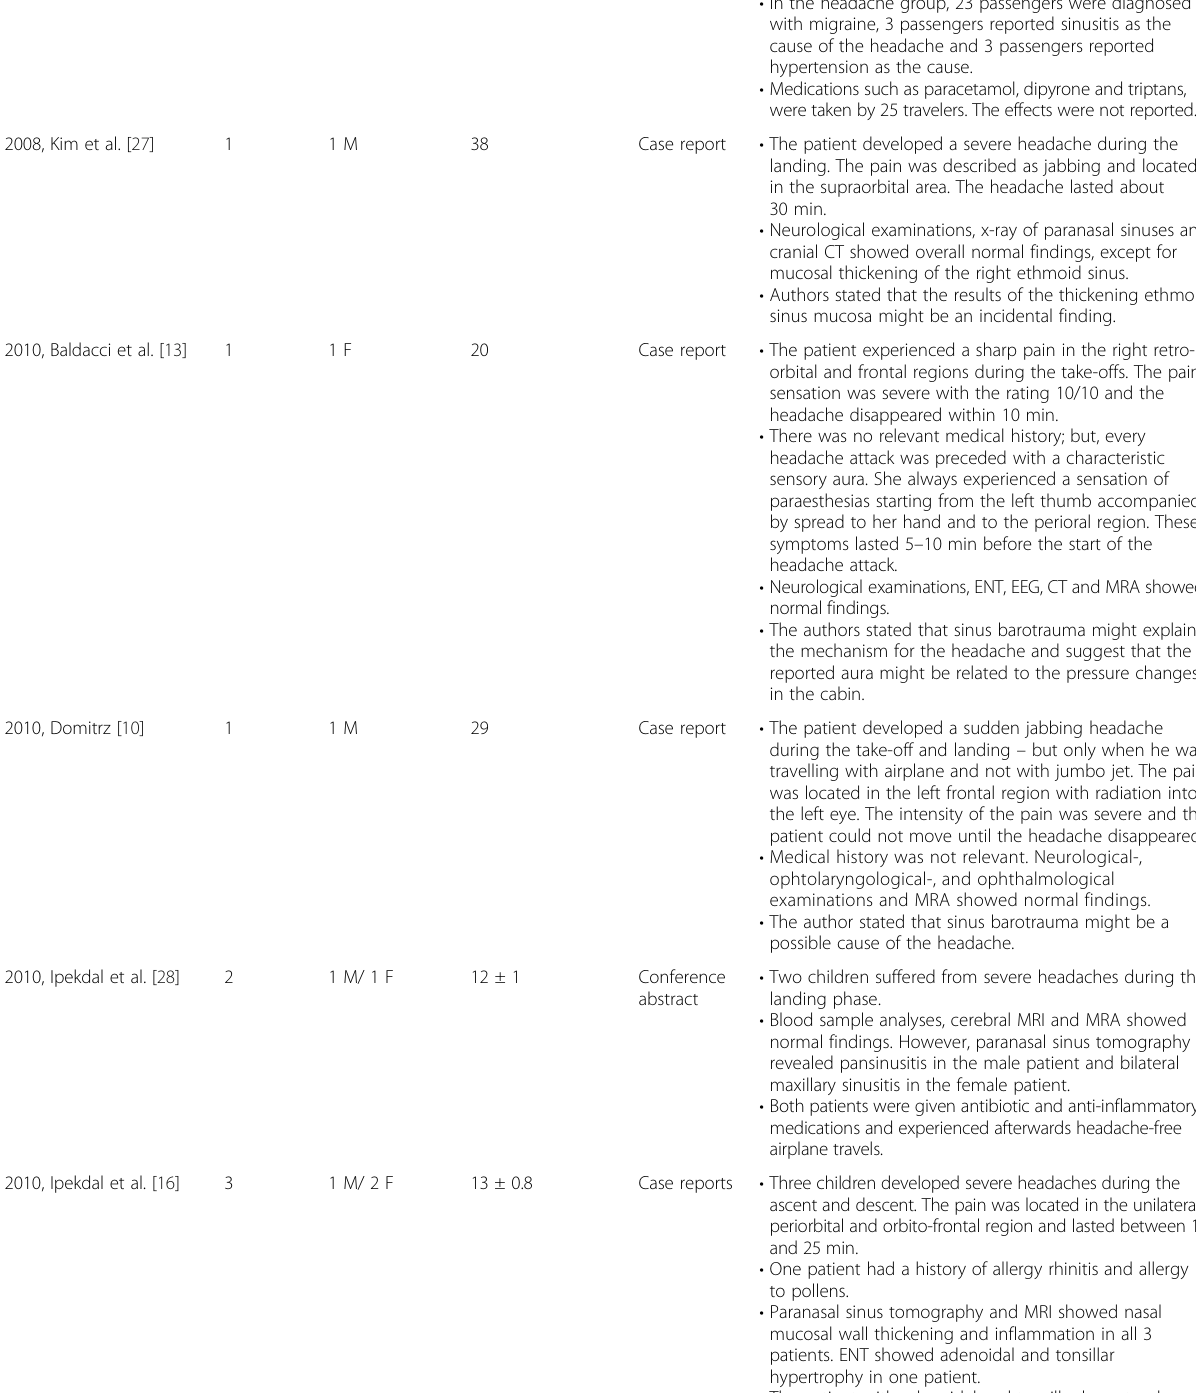
Table 1 Demographic characteristics and main outcomes of the current literature regarding headache attributed to airplane travel (Continued)